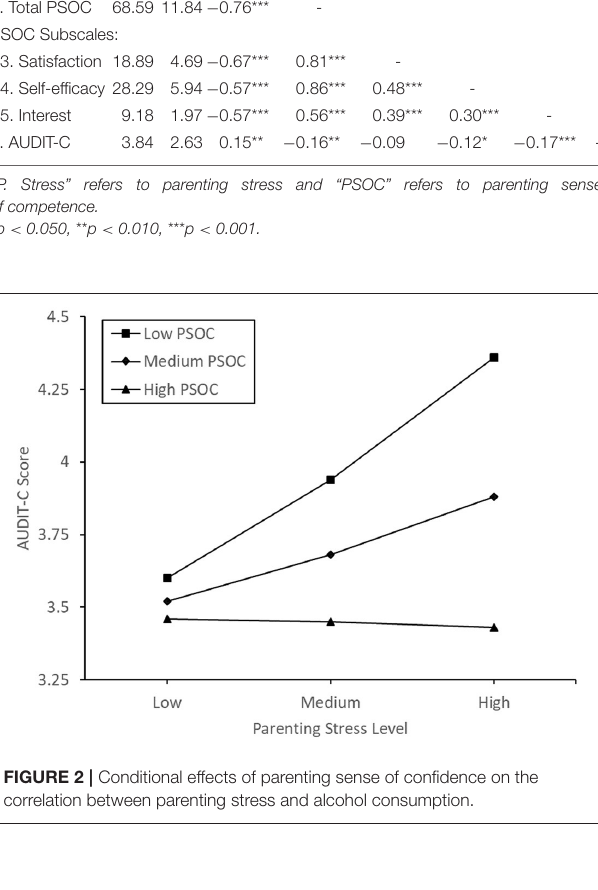
only self-efficacy (r = − 0.12, p = 0.013) and interest r = − 0.17, p < 0.001) were significantly correlated with AUDIT consumption score.